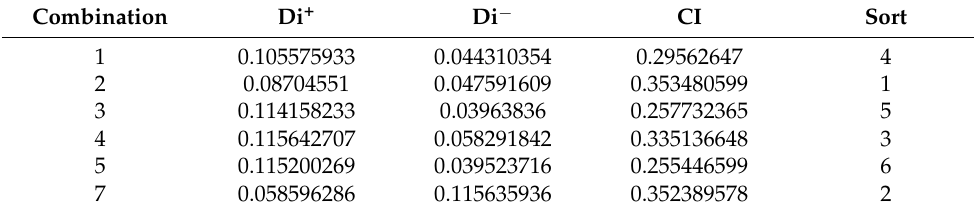
Table 8. Results of